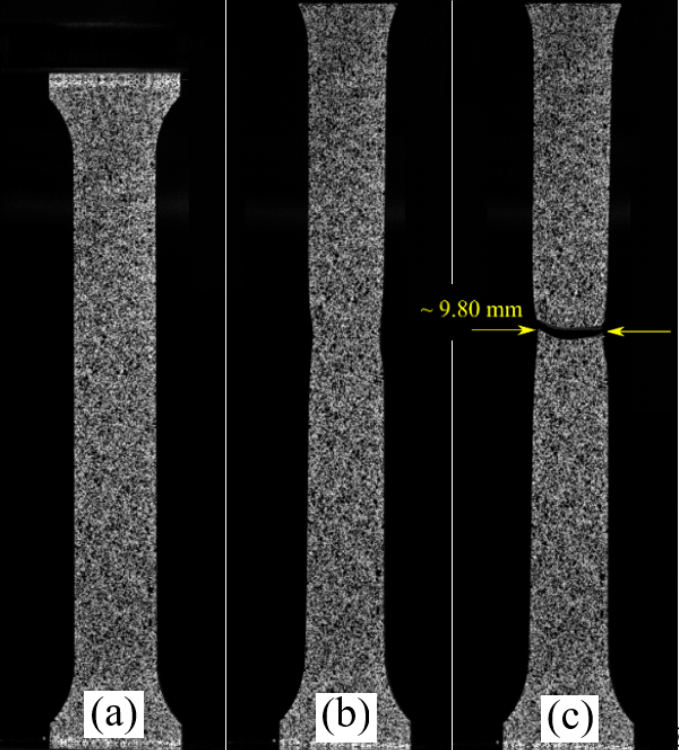
Figure 17. Images of the uniaxial tensile specimen during the testing at ( a ) the unloaded state, ( b ) immediately before the fracture, and ( c ) after the fracture. Table 7. Full set parameters of the GTN damage model for the CR980XG3 TM steel.